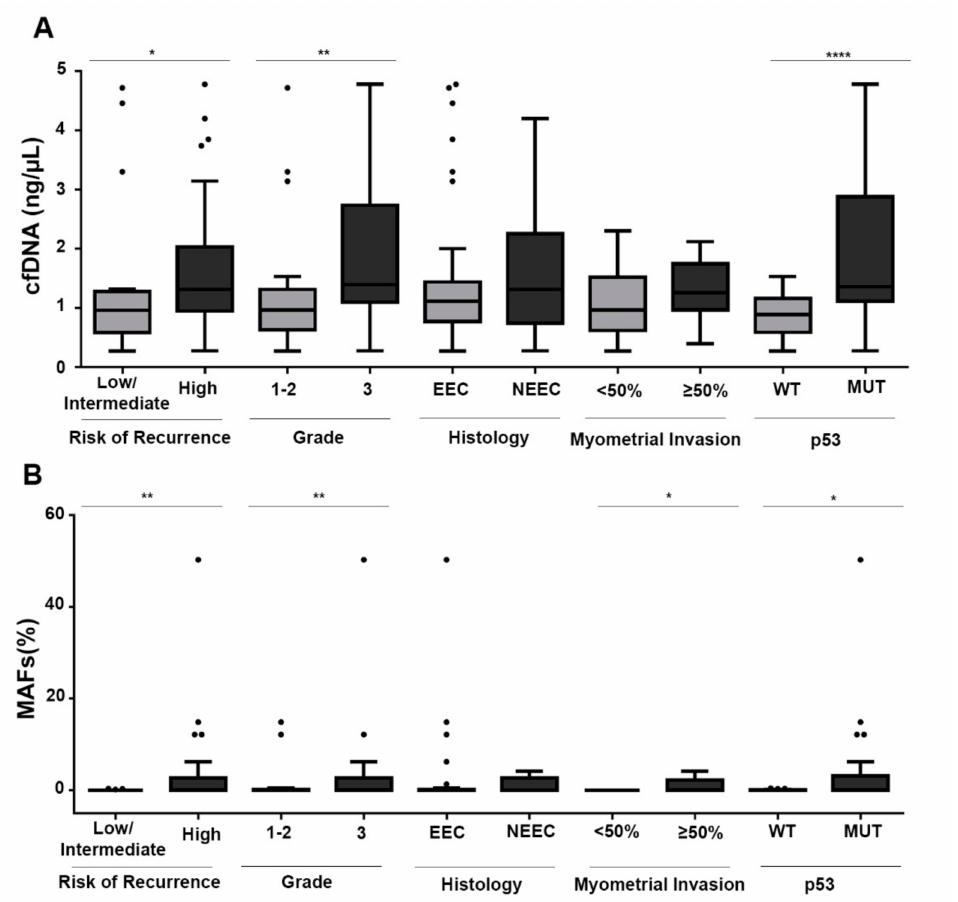
Figure 3. ( A ) Cell-free DNA (cfDNA) levels at surgery, grouped according to tumor grade, myometrial infiltration, risk of recurrence, and p53 status. ( B ) MAF (mutated allelic frequency) levels of